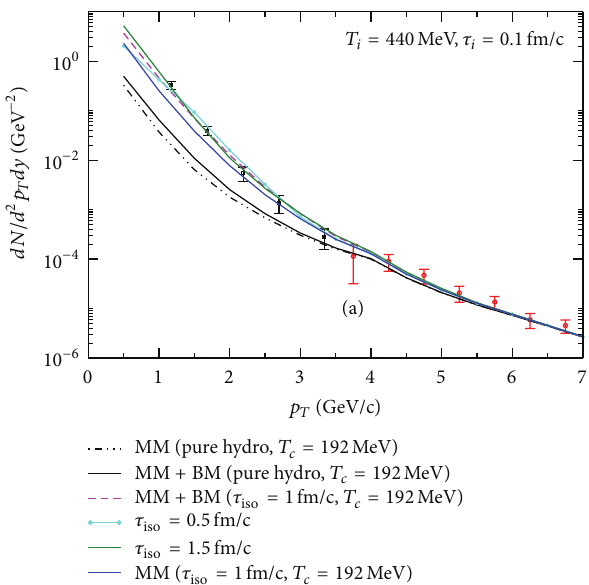
Figure 1: (Color online) Time evolutions of (a) the anisotropy parameter 𝜉 and (b) the hard momentum scale 𝑝 models described in the text. The graphs are taken from [15].